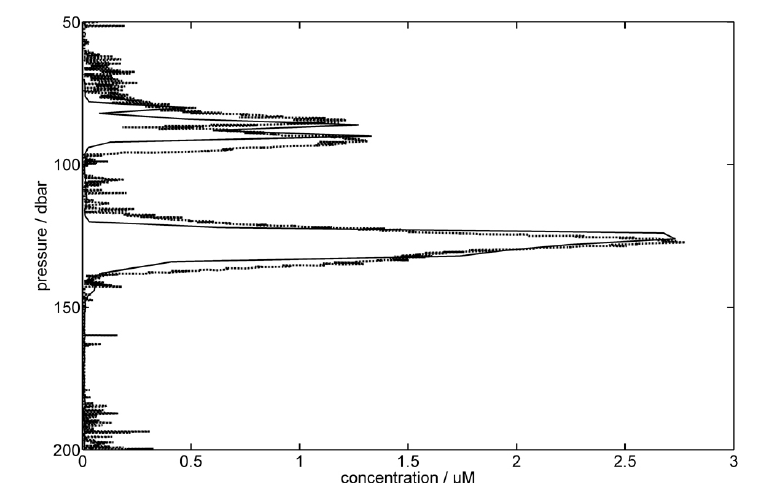
Figure 7. Comparison of bottle measured ICP-OES data (solid line) and METIS results (dashed line) after using ICP-OES concentrations to calibrate METIS absorbances.